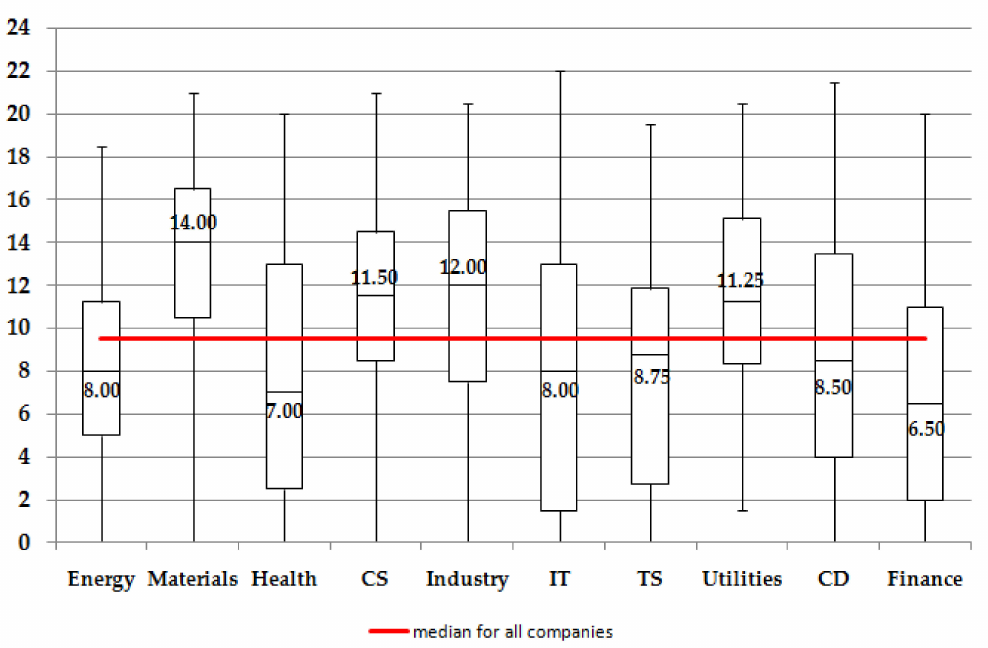
Figure 3. The distribution of overall grades in